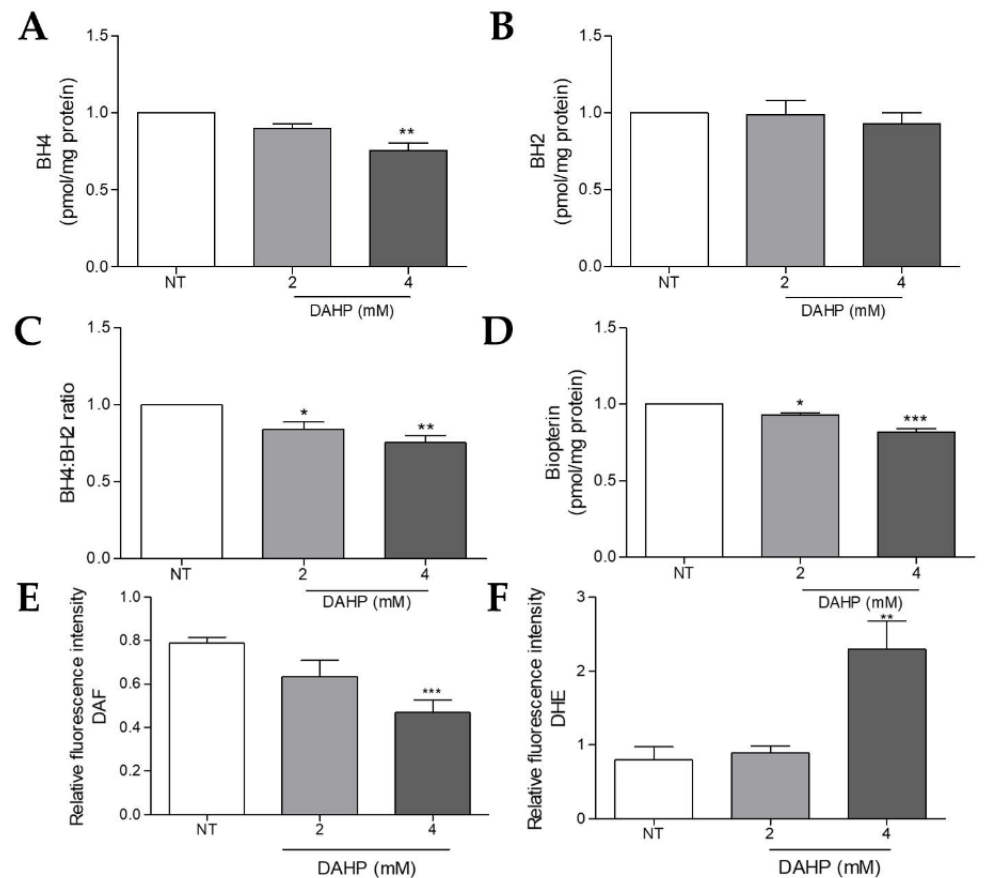
Figure 7. DAHP treatment reduced the intracellular BH4 and intensified the NOS uncoupling. WM983B cells were treated or not for 16 h with 2 and 4 mM DAHP, and the amounts of BH4 ( A ), BH2 ( B ), BH4:BH2 ratio ( C ), and total biopterin ( D ) were determined by HPLC. The NO amount